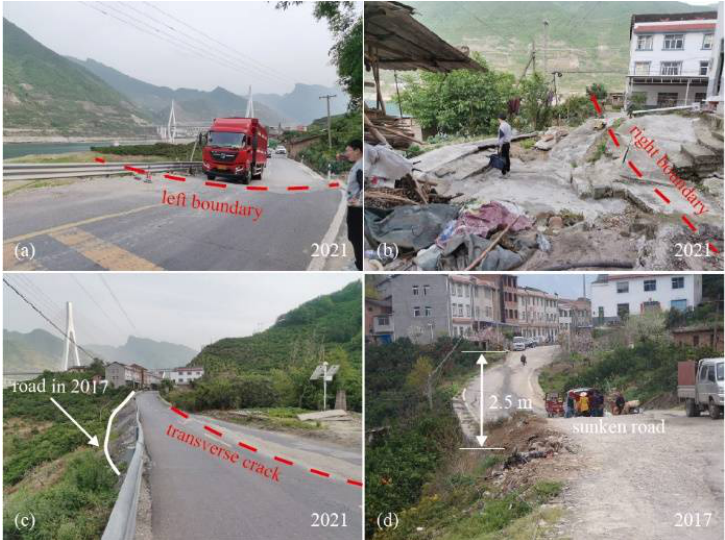
Figure 6. Deformation characteristics in the field. ( a ) Crack along left boundary in 2021; ( b ) Crack along right boundary in 2021; ( c ) Transverse crack on the new road in 2021; ( d ) the sunken road in 2017.